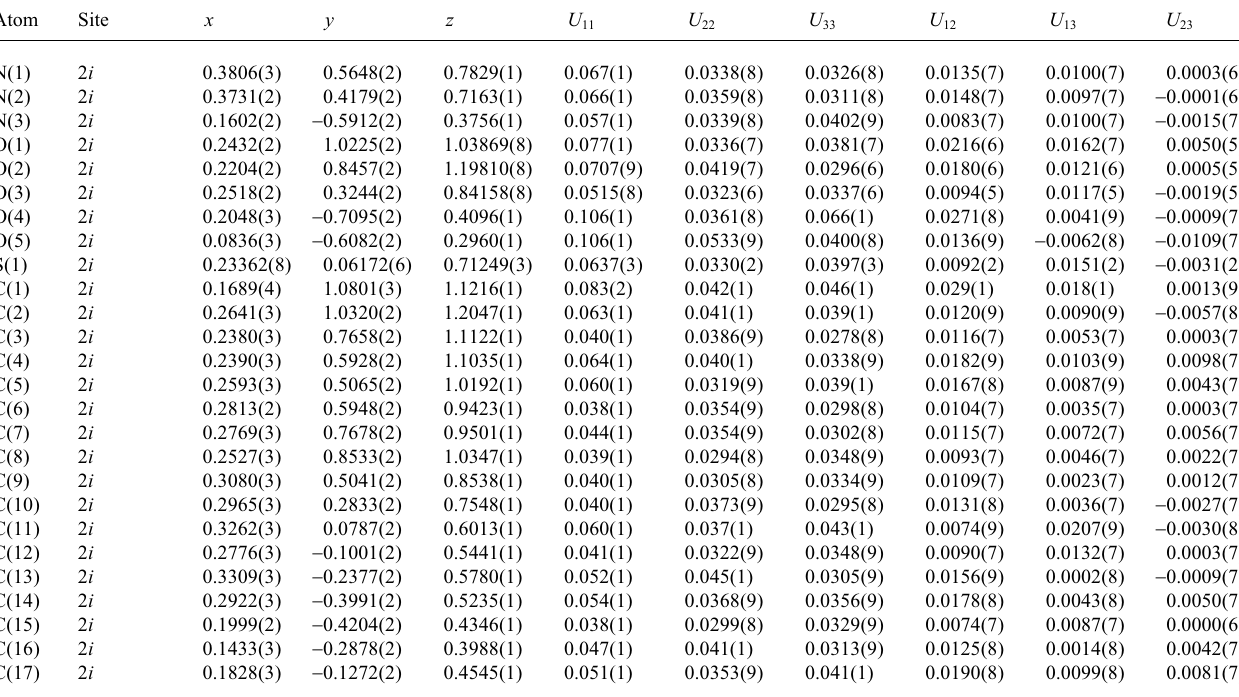
Table 3. Atomic coordinates and displacement parameters (in Å 2 )